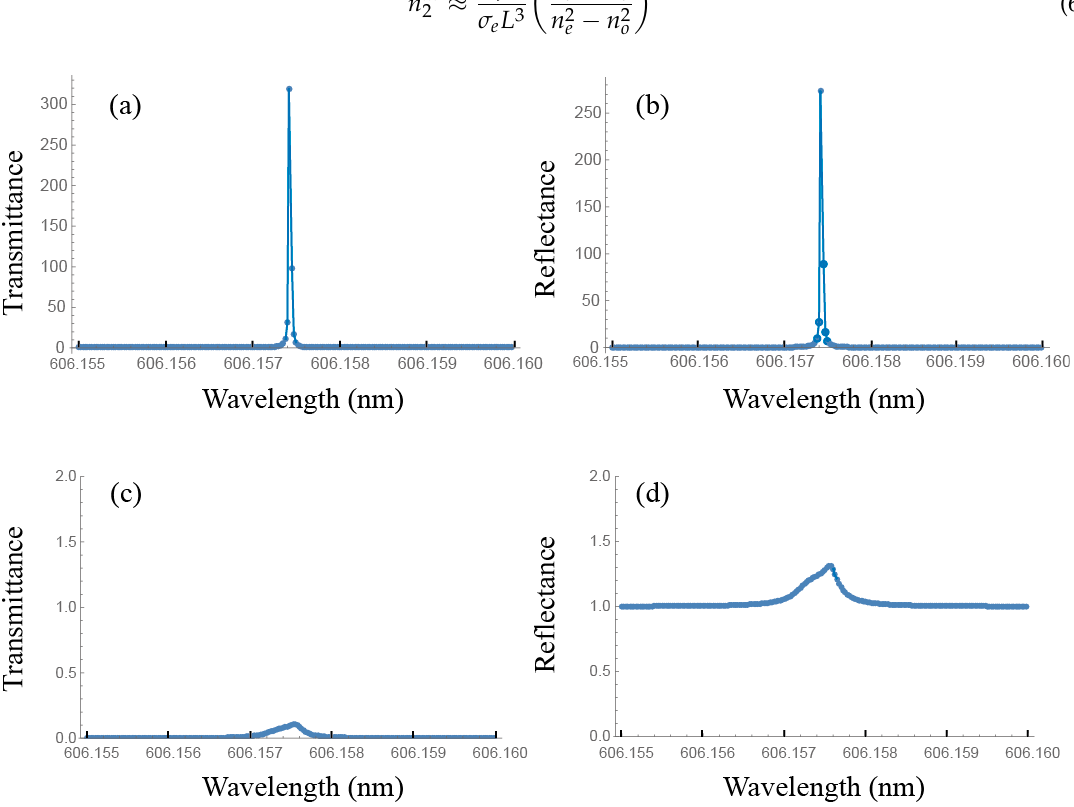
Figure 4 . Transmittance ( a ) and reflectance ( b ) versus wavelength for the lasing mode of the lowest threshold gain for the PLAL10PL sample; ( c , d ) are the transmittance and reflectance for the non-diffracting eigenstate under the same gain conditions. Table 2. Gain thresholds and percentages of excited dye molecules required for lasing in the different types of samples analyzed in the simulations.